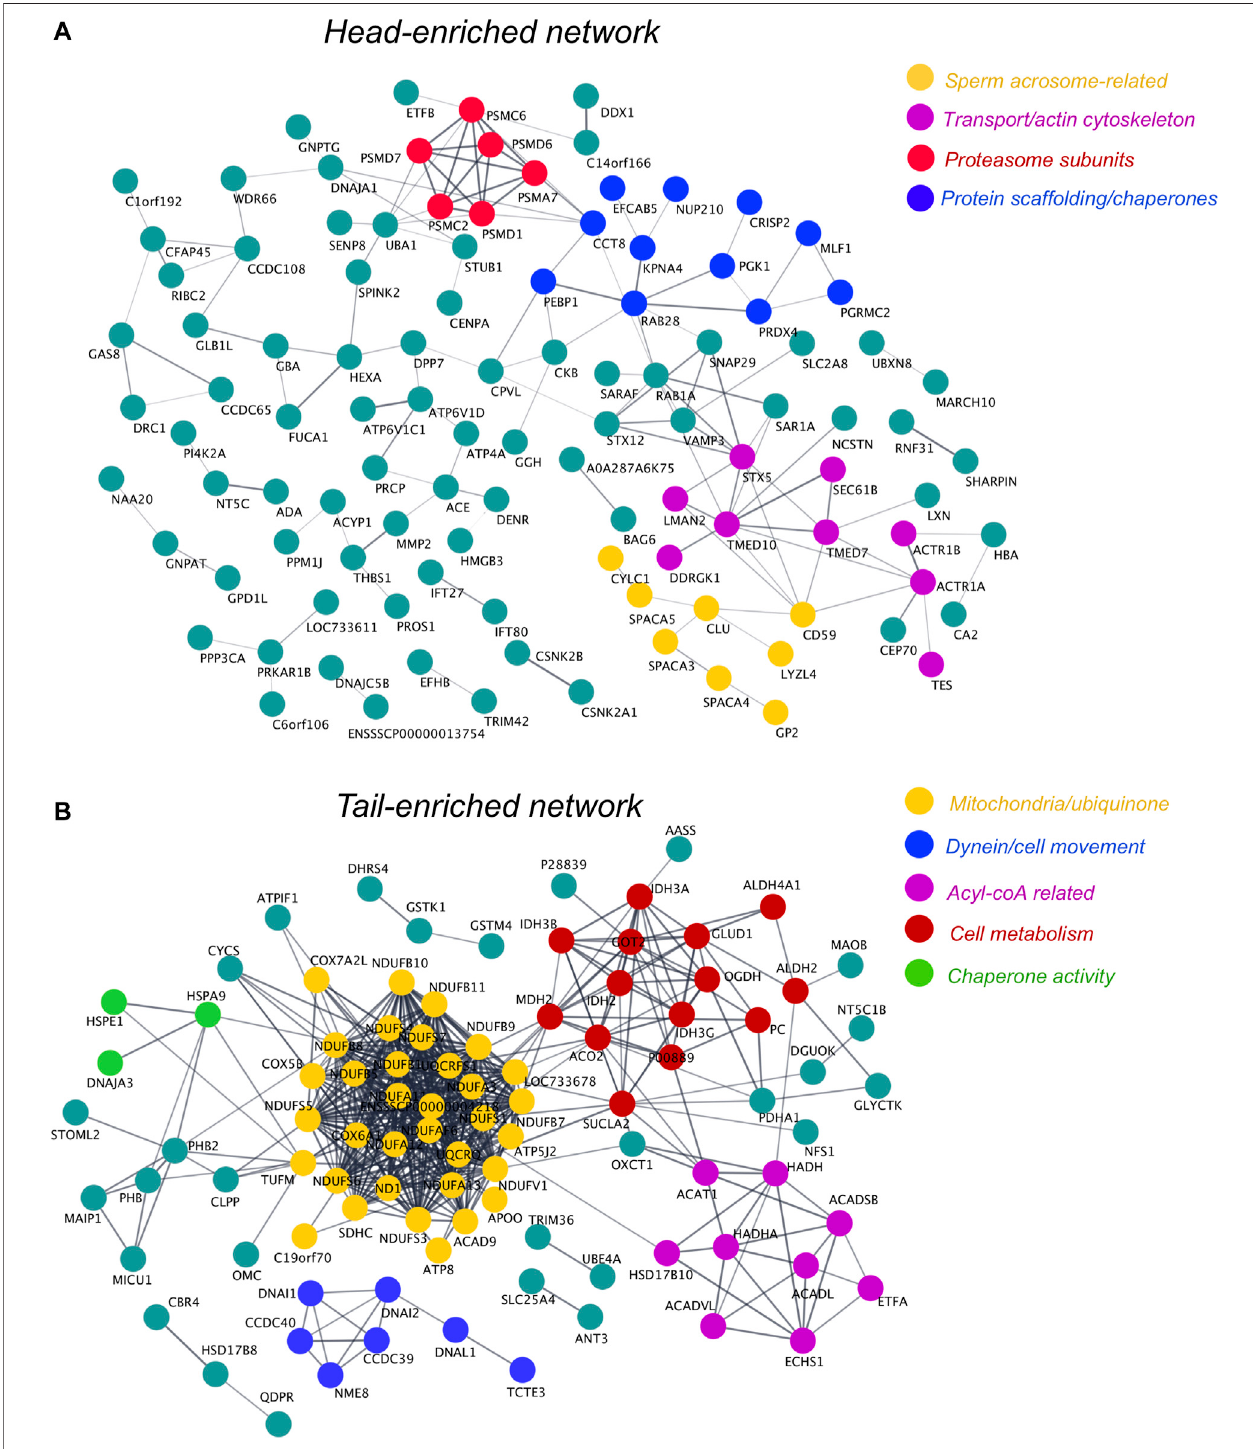
FIGURE 9 | Protein network analysis of head- and tail-enriched proteins within boar spermatozoa and identi fi cation of key protein clusters. To form each protein network, proteins signi fi cantly enriched in the sperm head (A) or tail (B) compared to the PT were uploaded via their Sus scrofa UniProt accessions to the online protein interaction database String. These protein networks were then exported to Cytoscape and protein clusters were manually designated functional annotations through literature searches of their protein components. Due to the limited annotation of the Sus scrofa proteome, several uncharacterized proteins feature in these networks. In the absence of an assigned gene name, these uncharacterized proteins were labeled with their UniProt accession number where possible. Single proteins that did not interact with other proteins within the head or tail networks can be found in Supplementary Figures S1B,C .